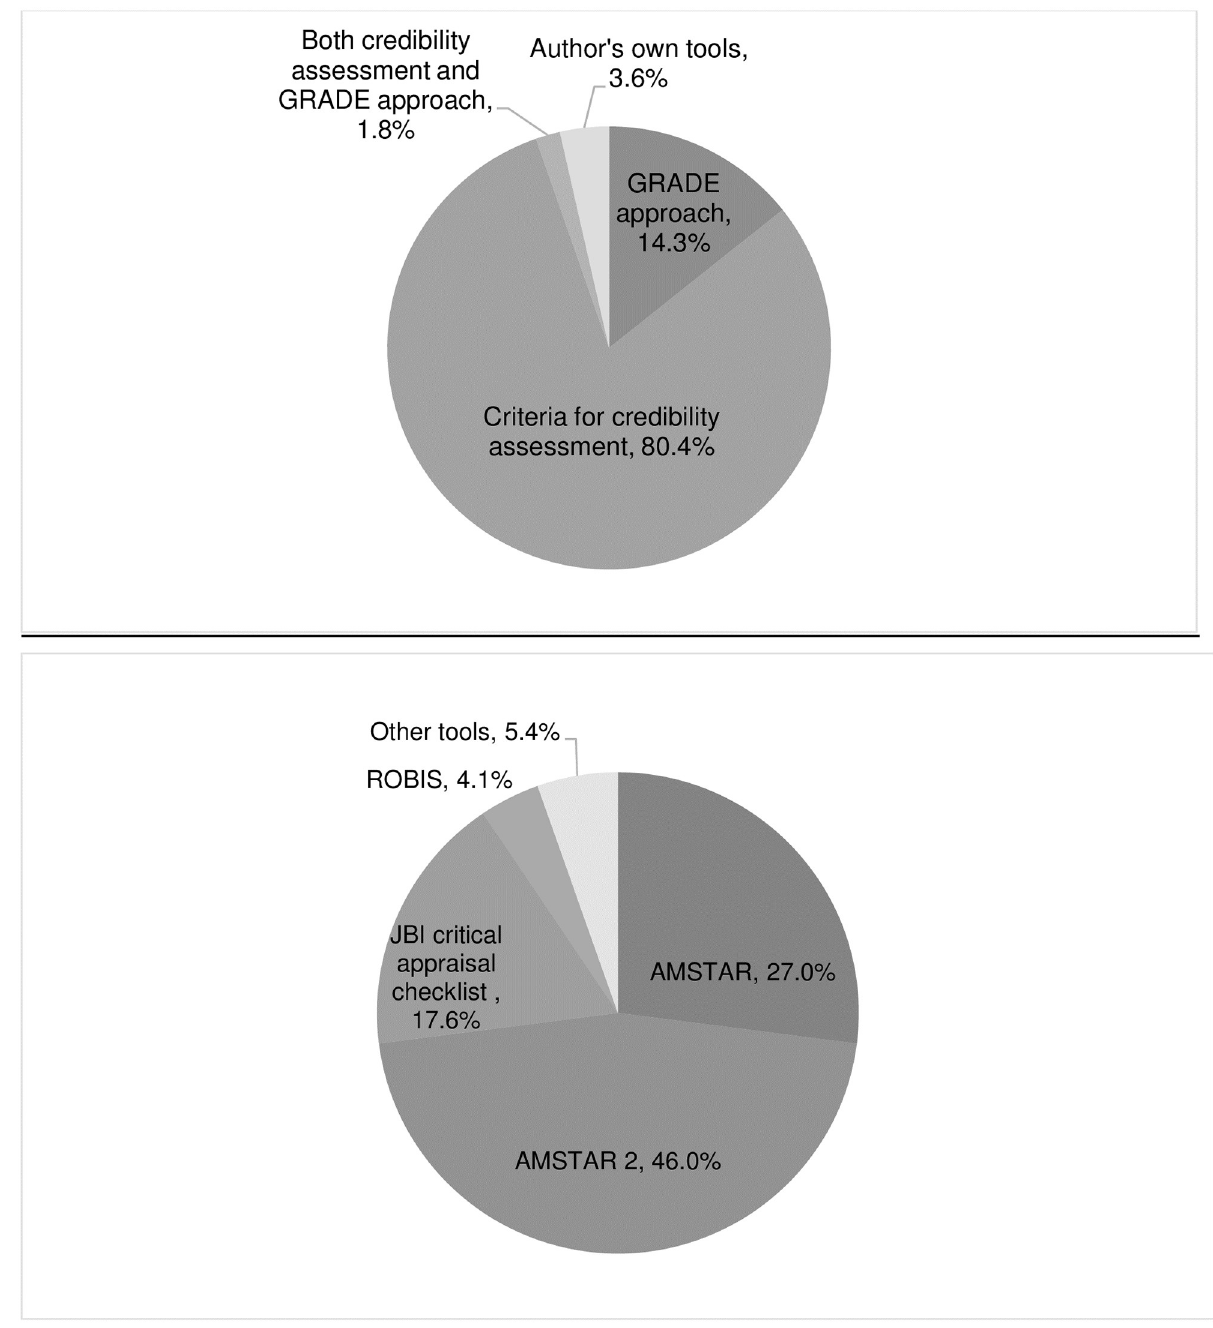
Fig 2. Percent used of methodological approaches for certainty and methodological quality assessment. (A) Methodological approaches for certainty of evidence assessment. (B) Methodological approaches for methodological quality